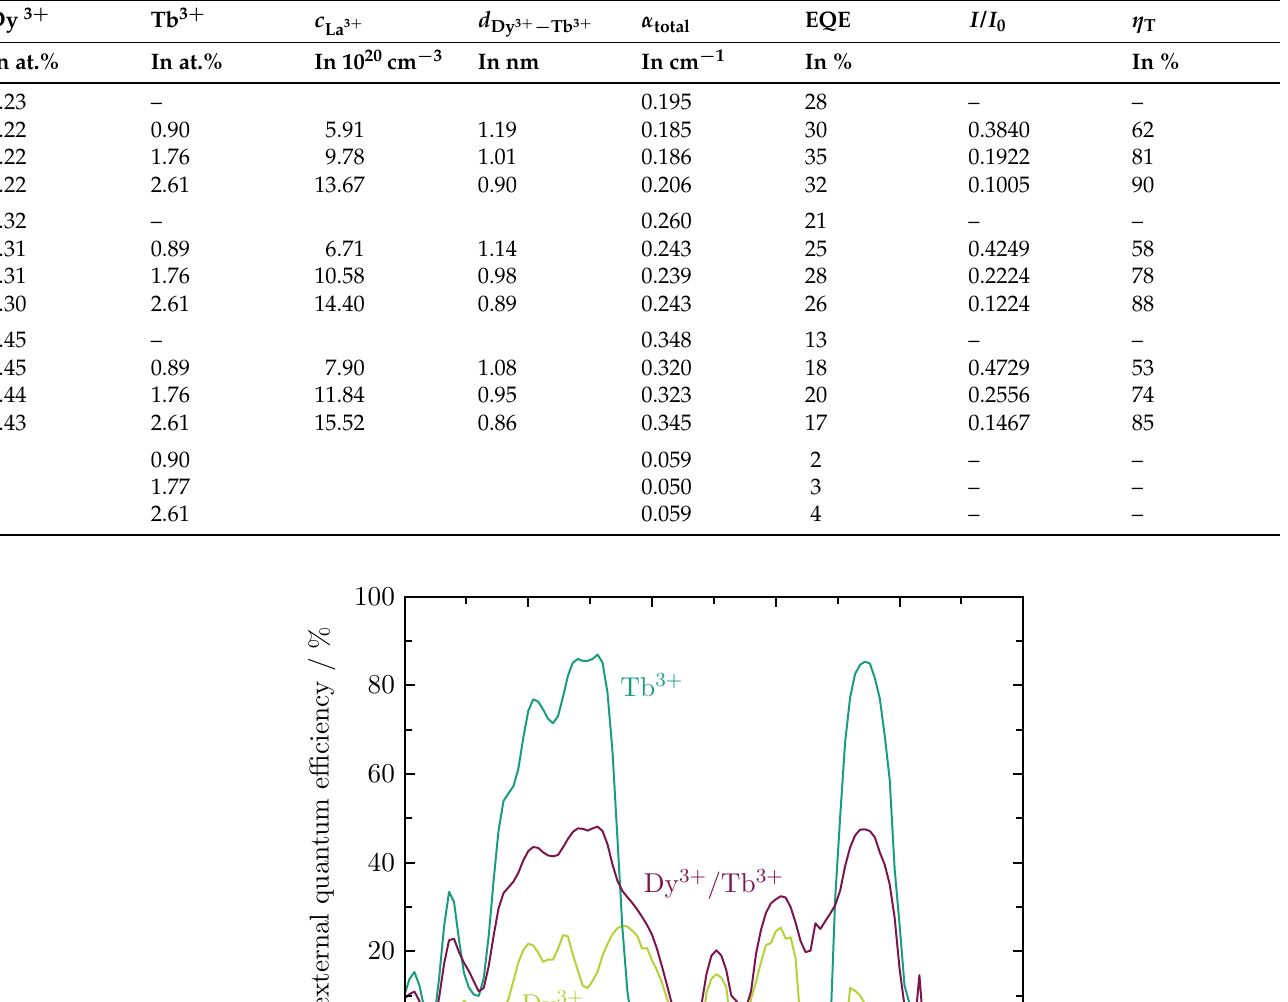
; mean Dy 3 + -to-Tb 3 + distance, d Dy 3 + Tb 3 + ; total La 3 + −